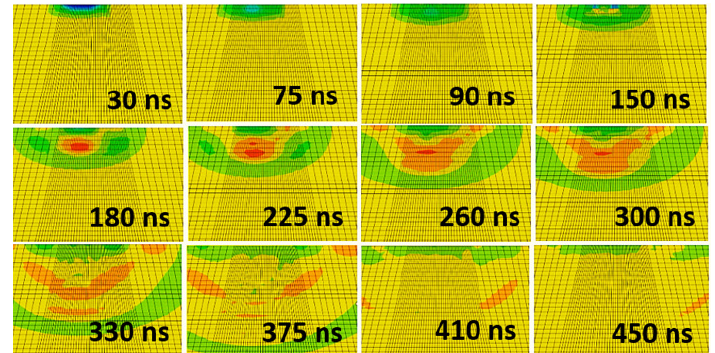
Figure 5. Propagation and attenuation of induced shock waves with respect to